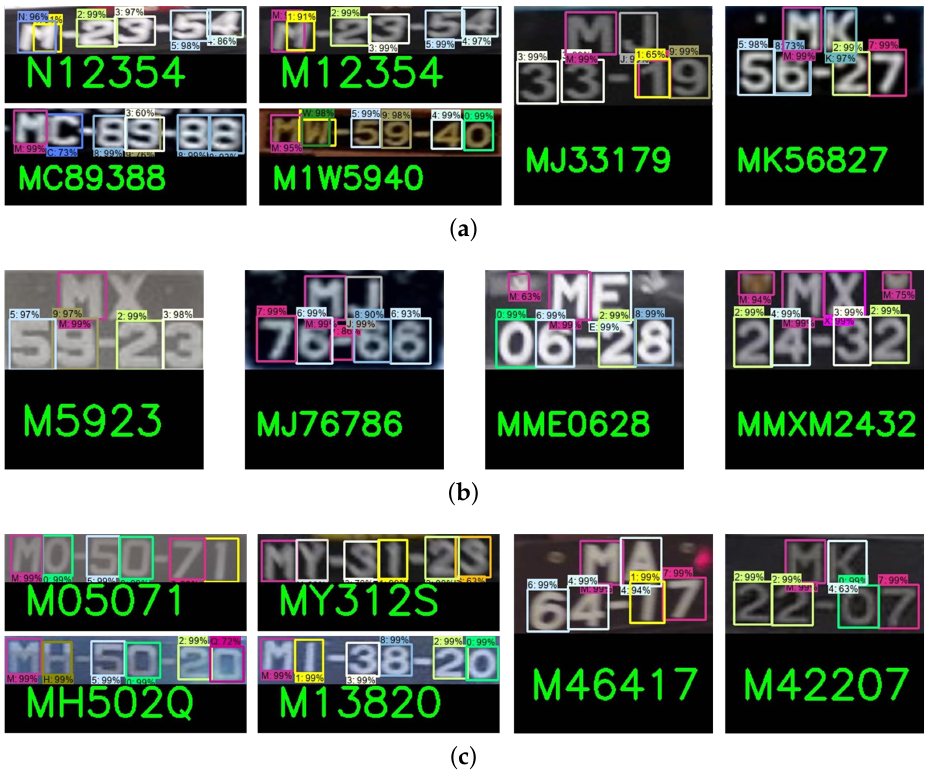
Figure 2. Some problems of character segmentation and recognition generated by the ROI detection approach. ( a ) Cross class problem. ( b ) False positives or missing detections. ( c ) Recognition confusion between letters and